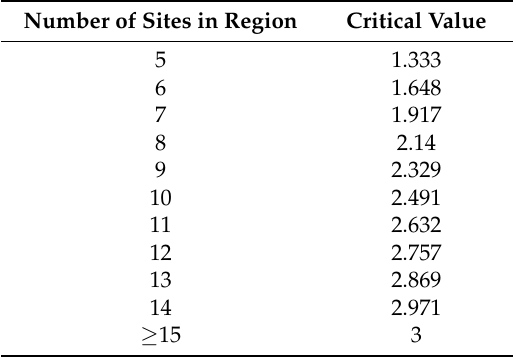
Table 2. Critical values for the discordancy statistic